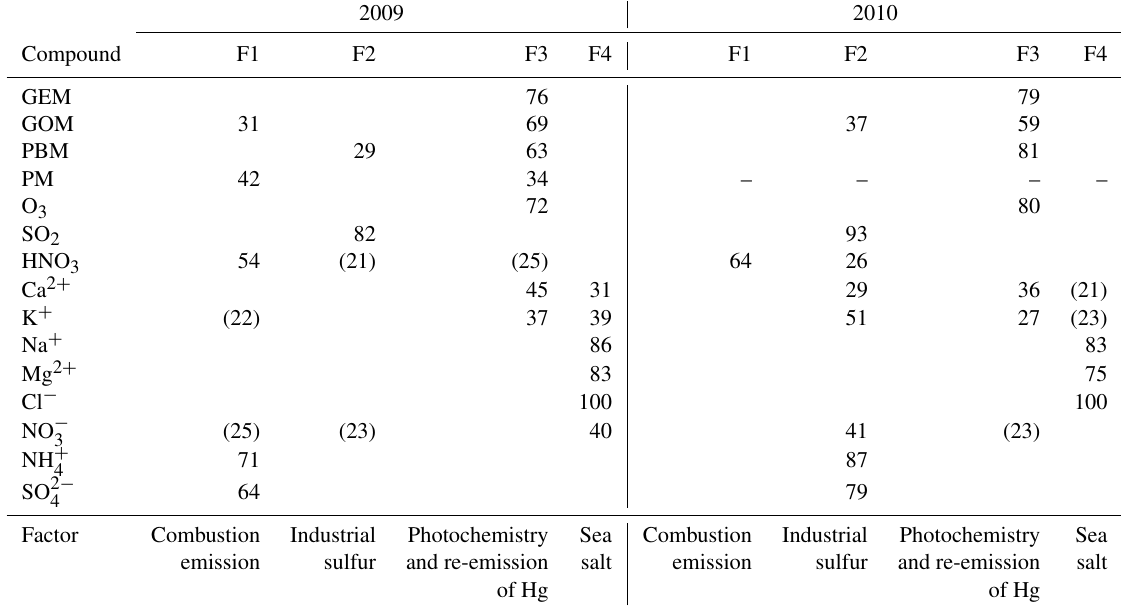
Table 5. Factor profiles (concentration>25%, between 20% and 25% in parenthesis) of Case 2009 and Case